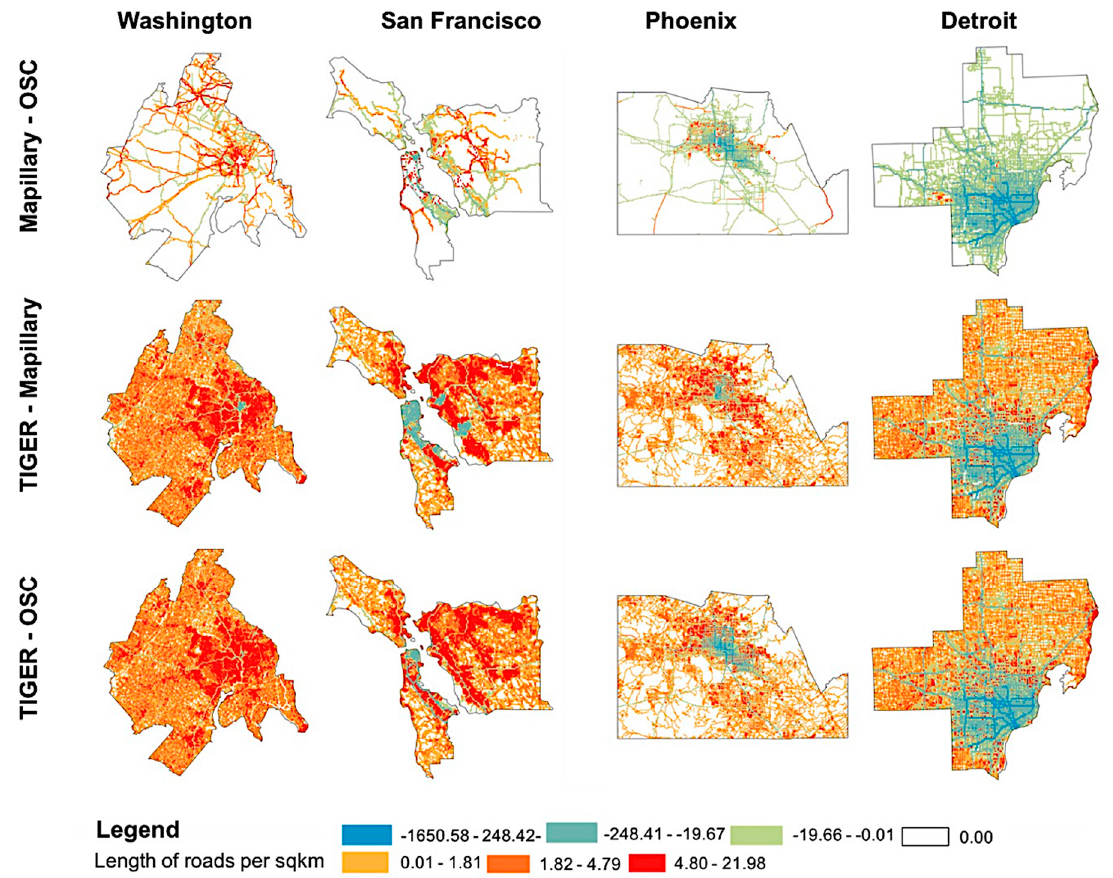
Figure 6. Spatial comparison of roads in kilometers.